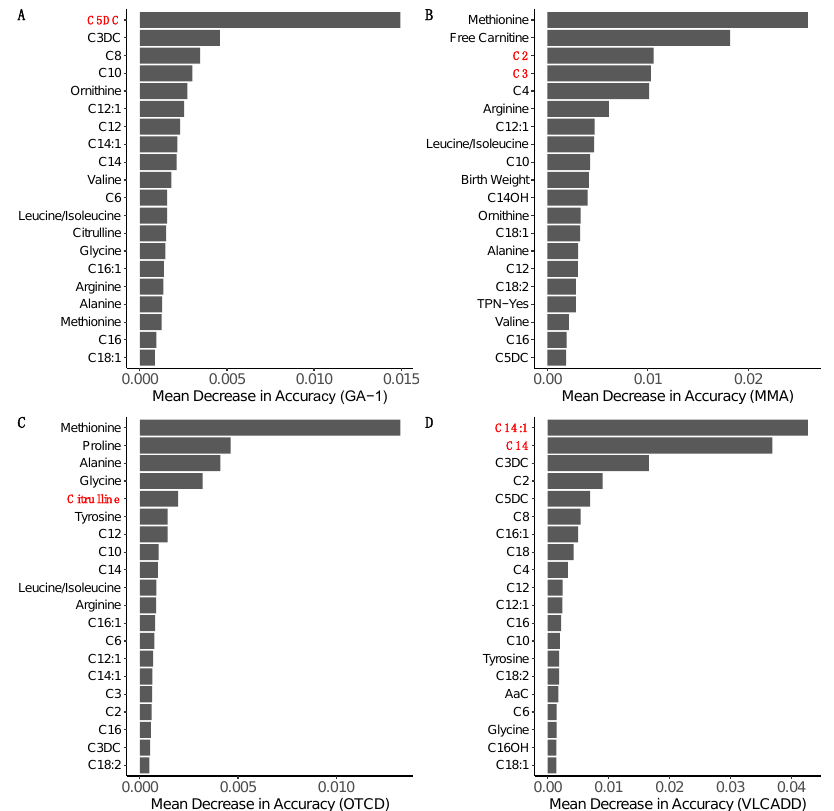
Figure 2. Assessing the performance of RF using cross validation. A 10-fold cross validation (1000 repeats) of the RF model was performed for each disorder to classify each screen positive as either a true or false positive. Only RF scores from testing samples were used to plot the ROC curve and to calculate the AUC. The small variation in AUC values without extreme outlier cases for each disorder demonstrates the overall stability of our RF model.